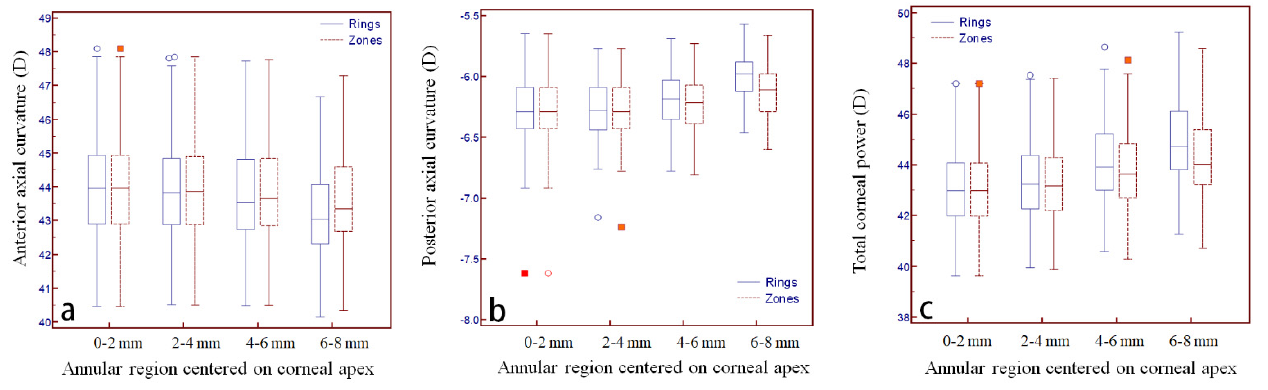
Figure 3. Box and whisker plot of the anterior axial curvature ( a ), posterior axial curvature ( b ), and total corneal power ( c ) changes with different rings and zones diameters centered on the corneal apex. Additionally, we found statistically significant differences between the AAC and TCP for the rings in different annular regions. The mean difference ranged from − 1.73 D to 0.90 D (Table 2, Figure 4). Similarly, significant differences were found in the zones of different annular regions, and the mean difference ranged from − 0.71 D to 0.90 D (Table 2, Figure 4). Comparing the different sub-regions, the smallest difference in the AAC and TCP between the rings and zones was found in the 4–6 mm annular range. Table 2. Mean difference between anterior axial curvature and total corneal power of different zones and rings centered on apex. Note: D = diopter; M = mean; SD = standard deviation. * Paired two-tailed t -test. Statistically sig- nificant values (at the 5% level) are in bold.